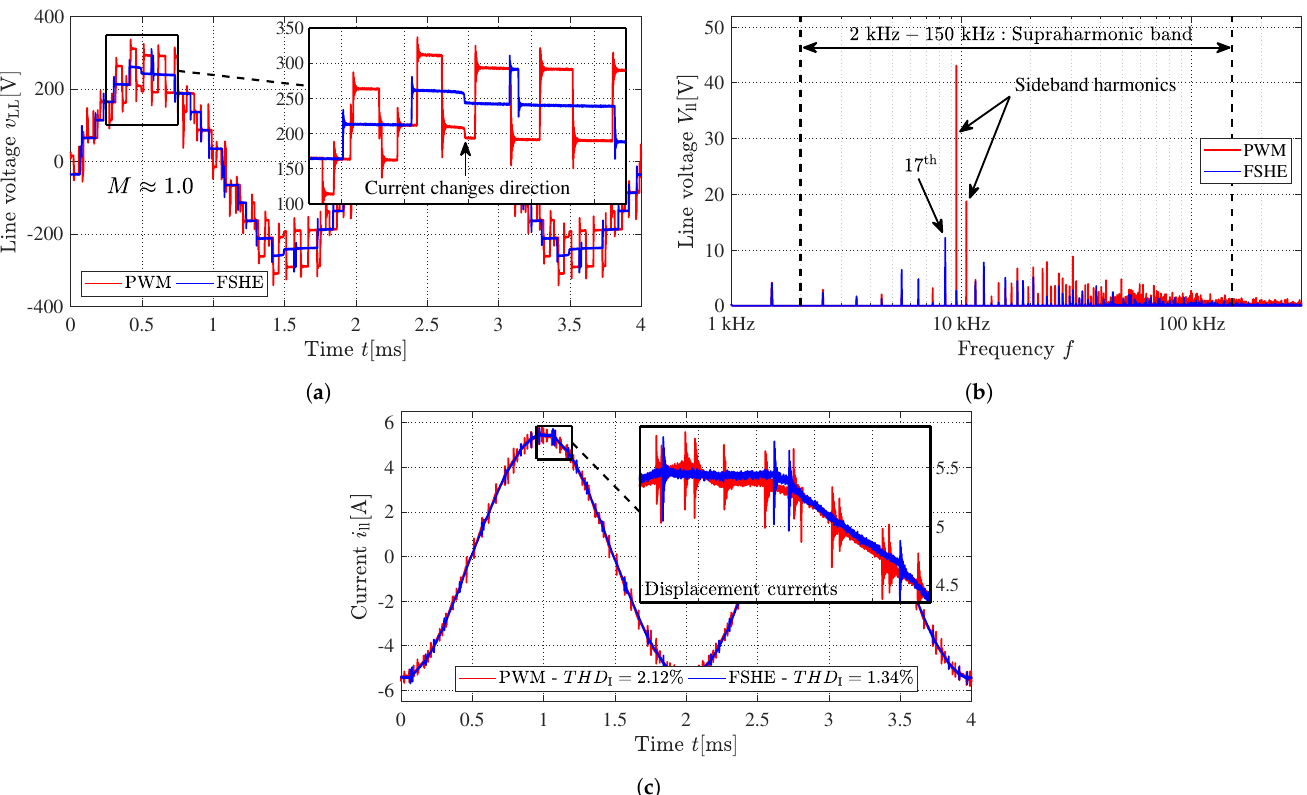
Figure 17. Measured ( a ) output voltage waveforms; including their ( b ) harmonic components; and ( c ) line current when operating the CHB inverter with multilevel PWM and FSHE for a modulation index of M ≈ 1 ( f 1 = 500Hz and f sw = 10kHz).